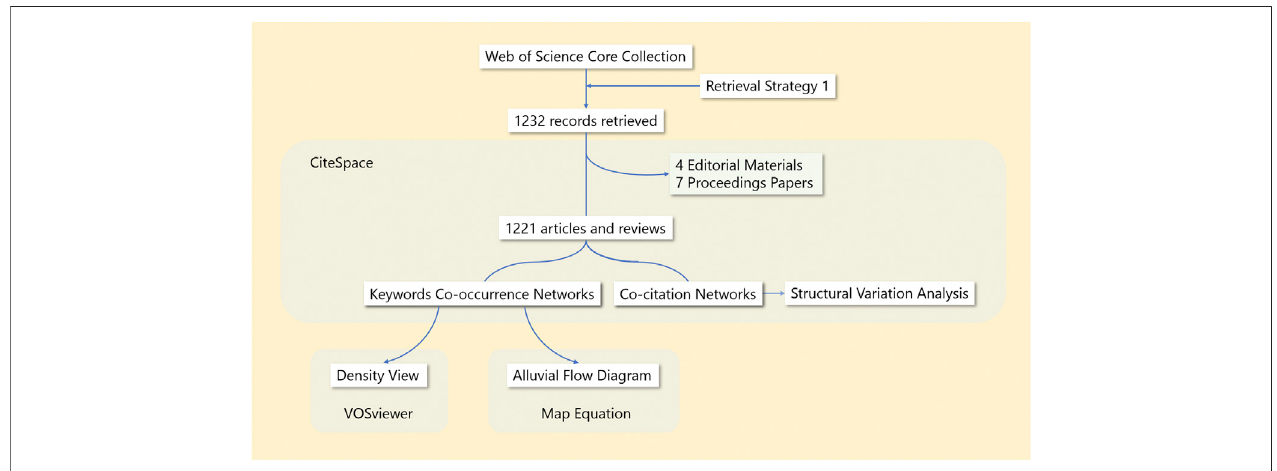
FIGURE 1 | The work fl ow of our